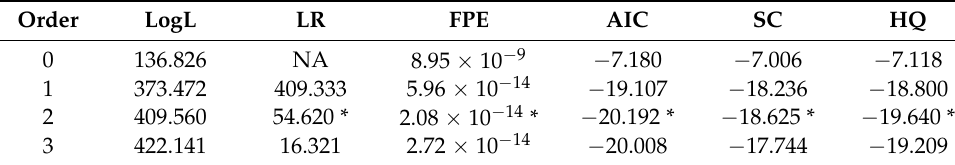
Table 5. Test statistics and choice criteria for selecting the order of the model.